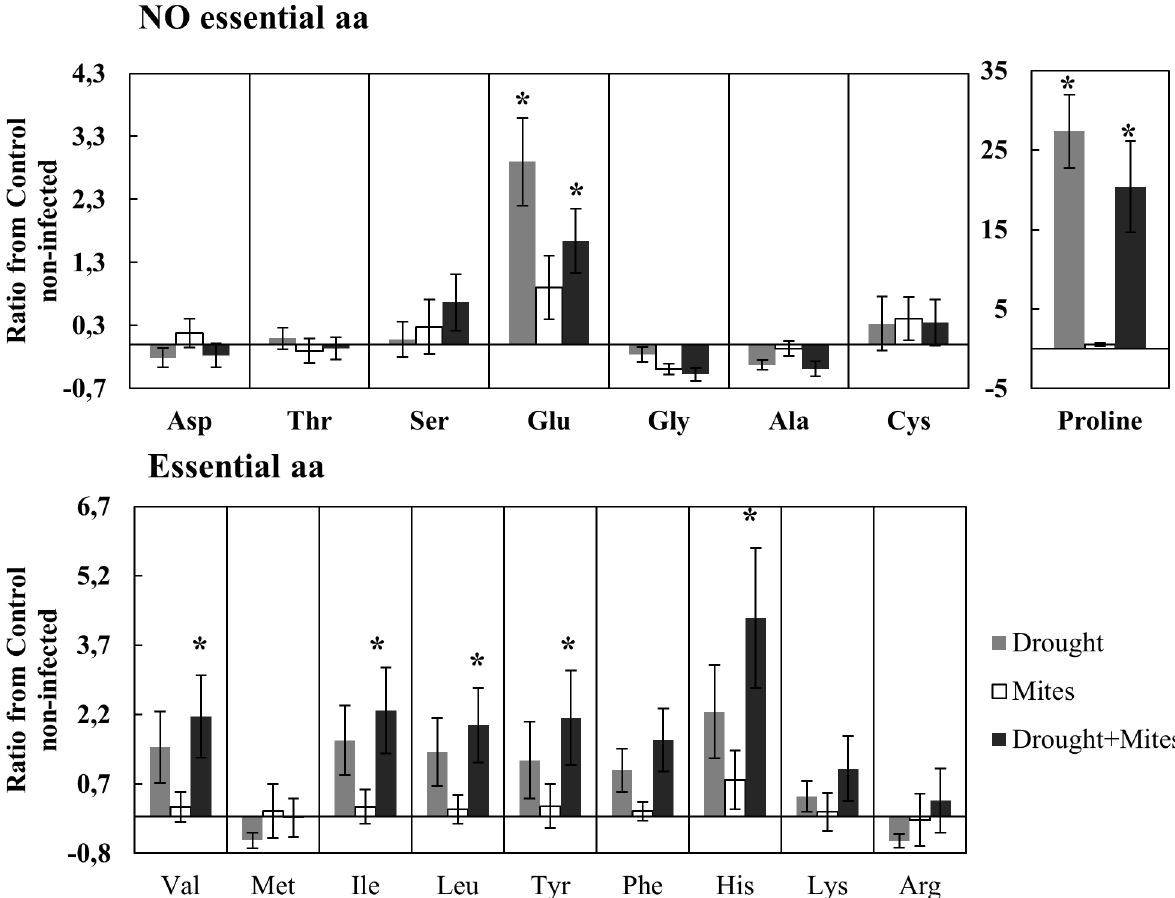
Fig 4. Levels of free amino acids in tomato leaves subjected to moderate drought stress and T . evansi infestation at 10 days post infestation (dpi). Data represent the ratio ± SE of the different treatments with respect to non-infested control plants at 10 dpi. = [(Treatment − Control 10dpi) / Control 10dpi]. The division between essential and nonessential amino acids is based on a study with the closely related species Tetranychus urticae [32]. * Indicates significant difference of the treatment with the control determined by Dunnet post hoc test p < 0.05.